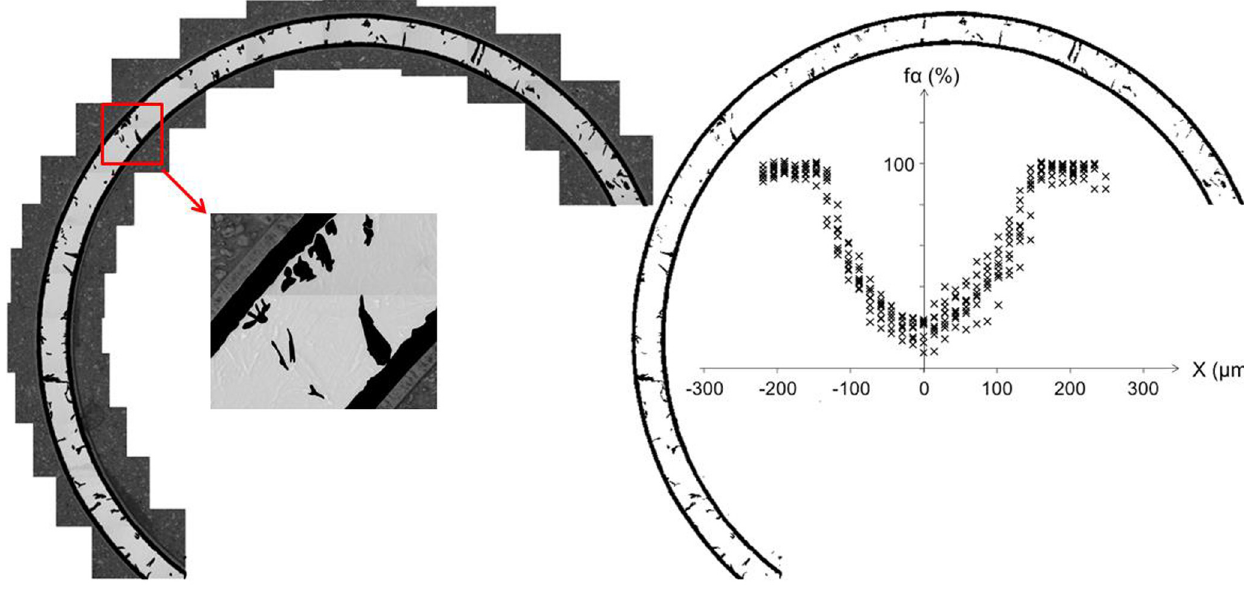
Fig. 3. Example of transformation of the optical metallography into a binary image used to determine the experimental average phase fraction radial pro fi le (sample labelled H66-7).